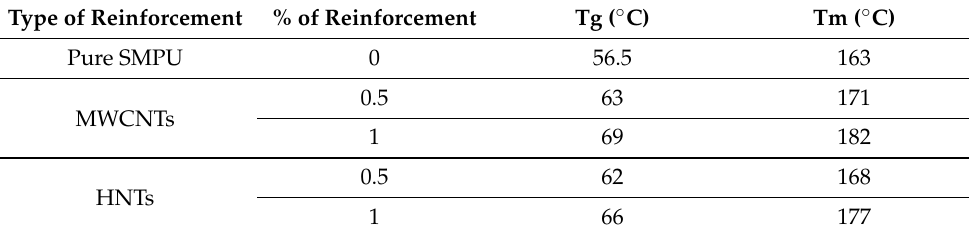
Table 3. Tg and Tm values of all the composites considered in the present study [24]. Type of